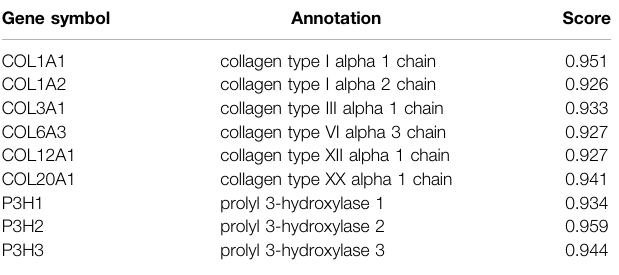
TABLE 4 | The detailed information of P4HA3-related